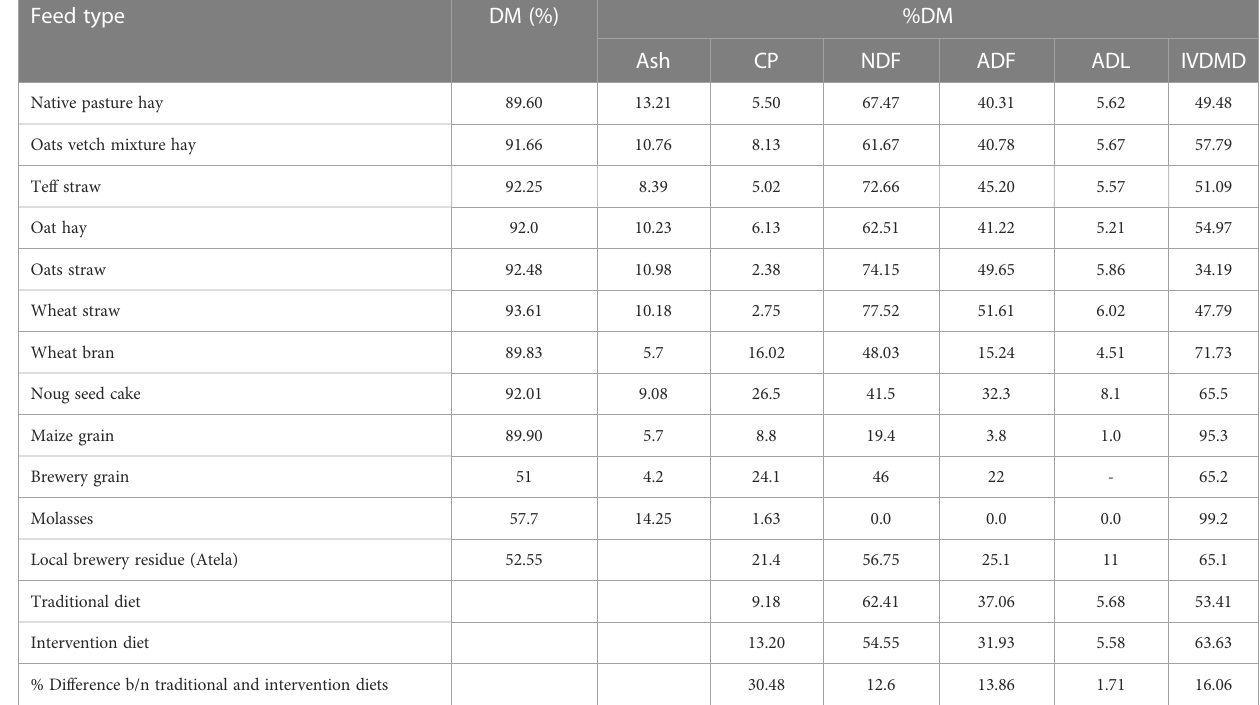
TABLE 2 Chemical composition and in-vitro dry matter digestibility of feed ingredients and dietary treatments used in the feeding trial. Feed type